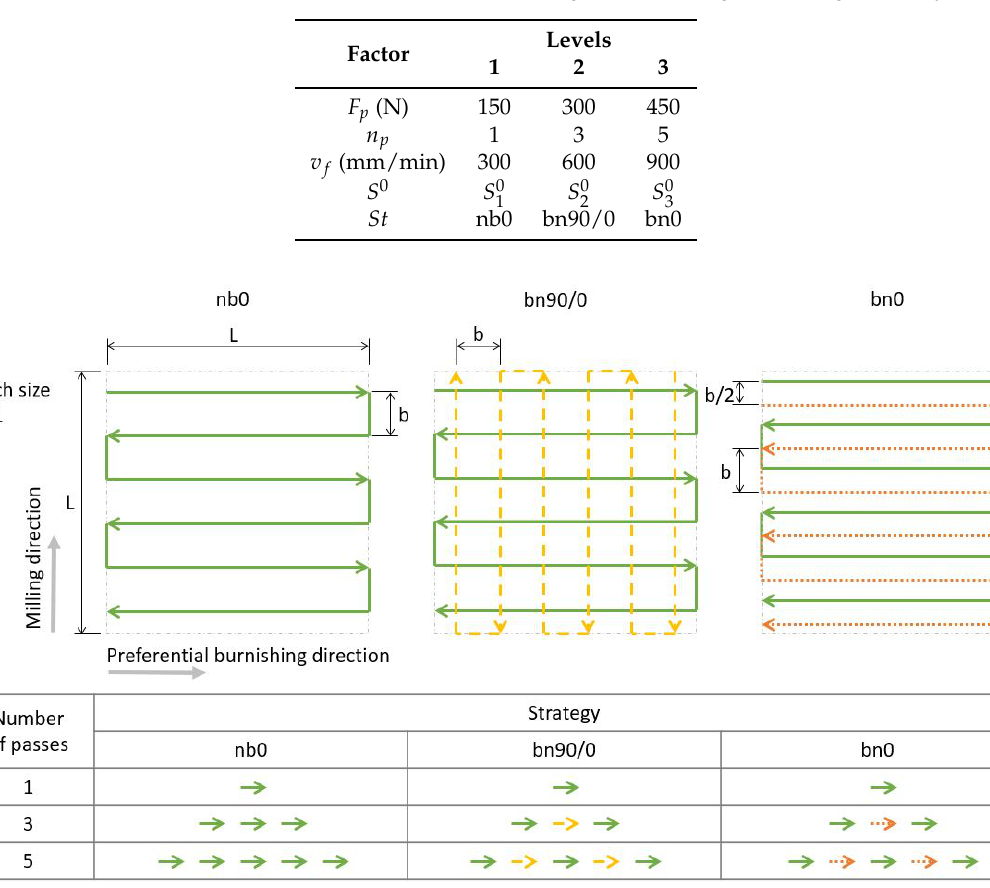
Table 4. Factors and levels considered in the DOE to generate the Taguchi orthogonal array.